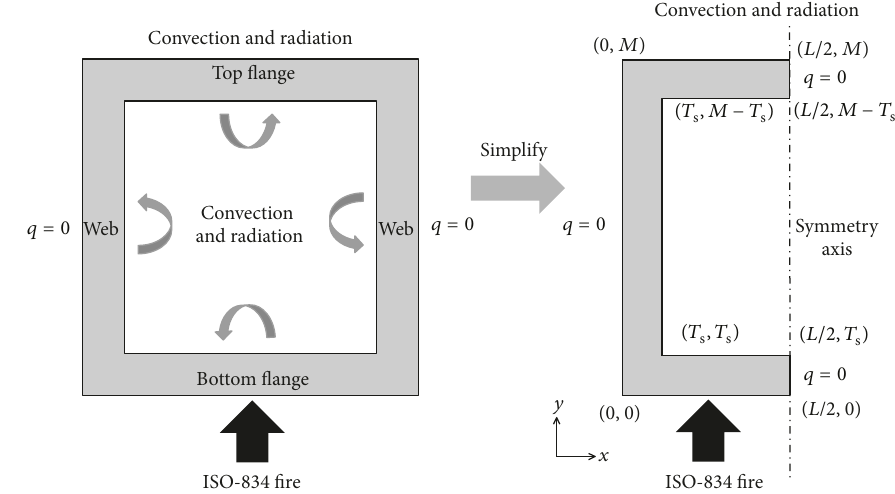
Figure 1: Thermal boundary conditions of GFRP rectangular